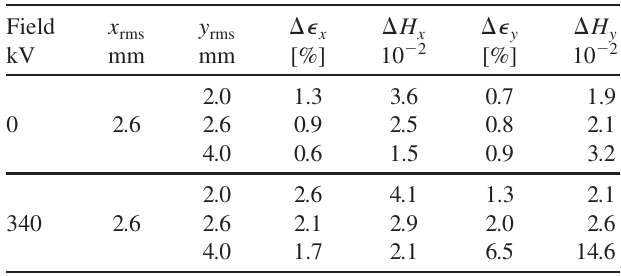
TABLE X. Aspect ratio dependence—Gaussian beam